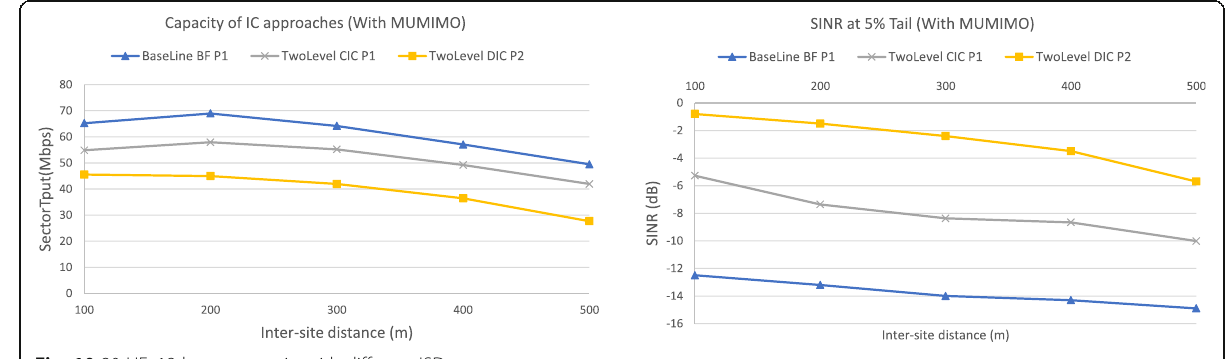
Fig. 10 20-UE, 12-beam scenario with different